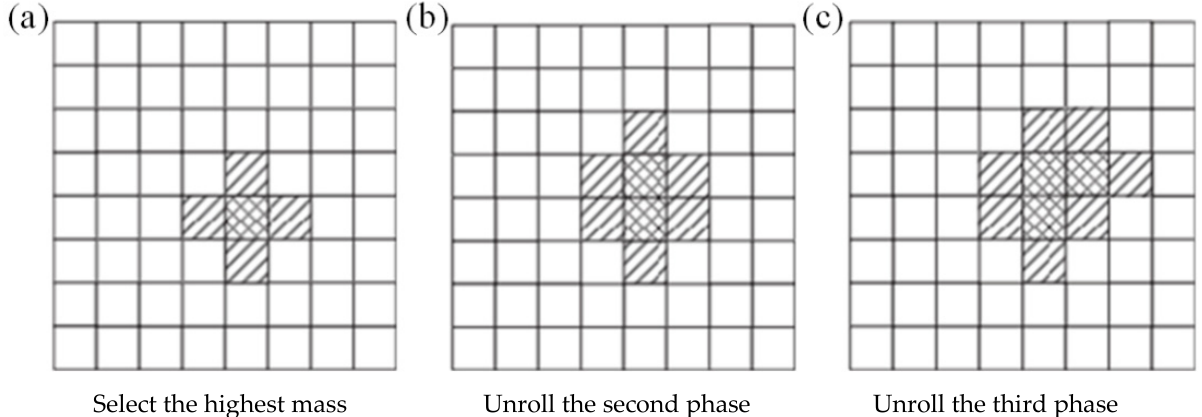
Figure 2. Phase unwrapping method for quality image.